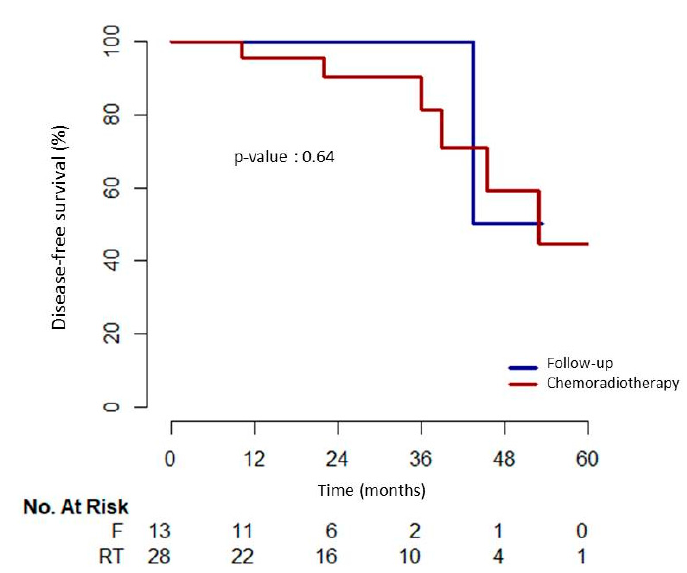
Figure 2. Disease free survival in the chemoradiotherapy and follow-up groups.